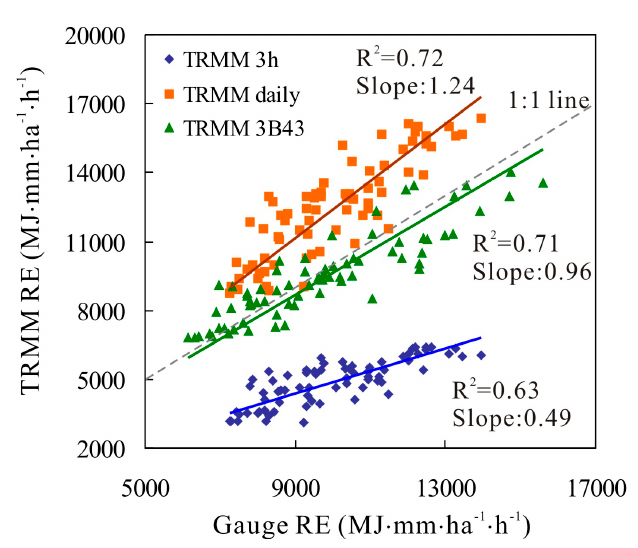
Figure 10. Scatter plots of annual rainfall erosivity at rain gauges against their nearest satellite pixel.